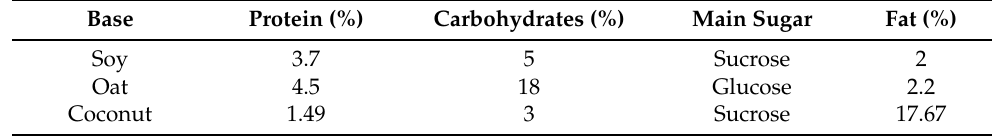
Table 3. Nutritional content of the unfermented bases produced for this